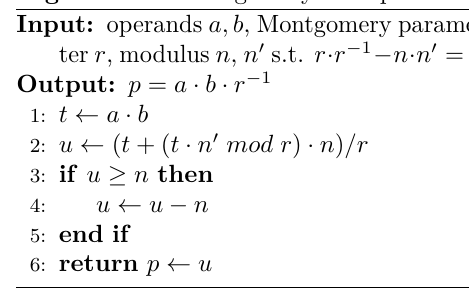
Algorithm 7 Sliding window exponentiation Algorithm 8 Montgomery